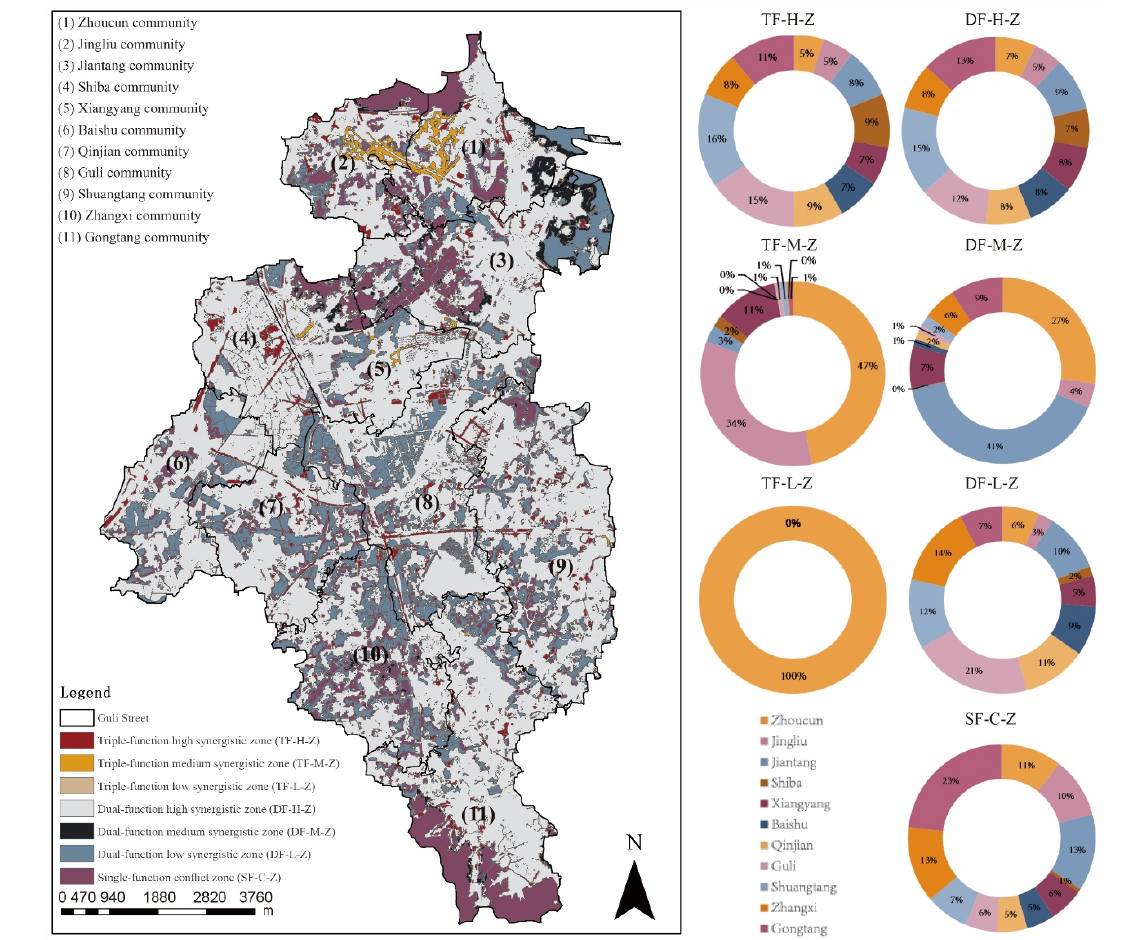
Figure 10. Identification of potential areas of PLE synergies and identification of village-specific areas.